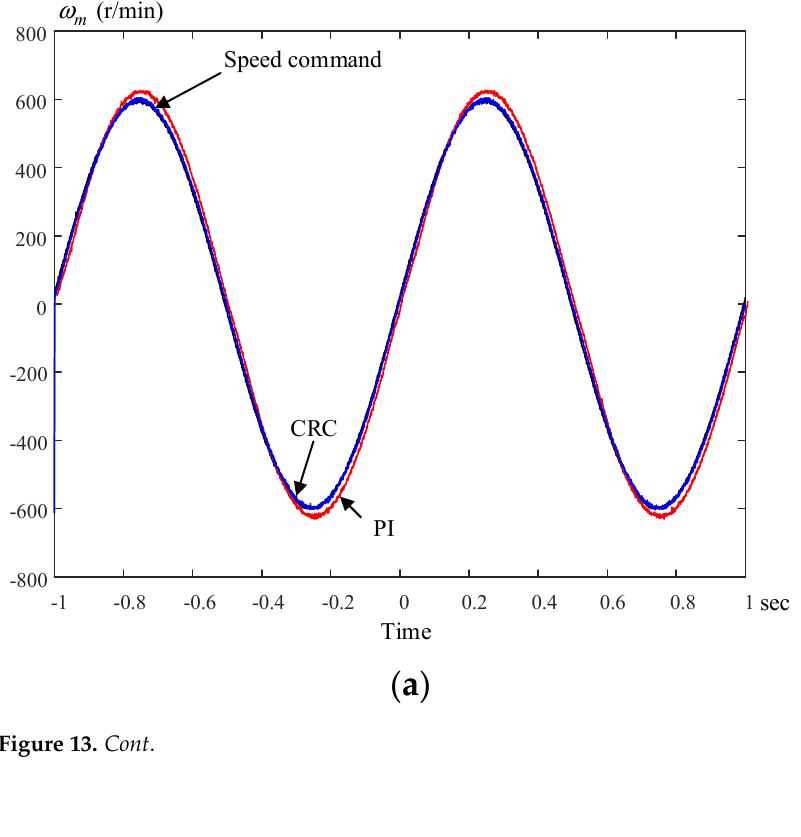
Figure 12. The measured waveforms of three-step commutation.